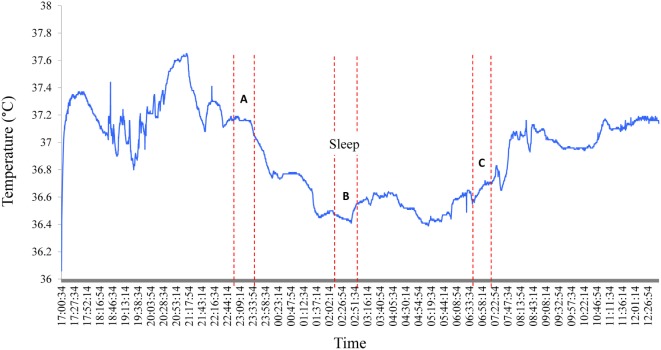
Nocturnal changes in core body temperature in one subject. A typical Tc profile for one subject shows the nycthemeral and nocturnal decline in Tc. A, B, and C correspond the following time periods: (A) the highest 30-min average value before sleep onset, (B) the lowest 30-min average value during sleep, and (C) the first 30-min average value after arousal.